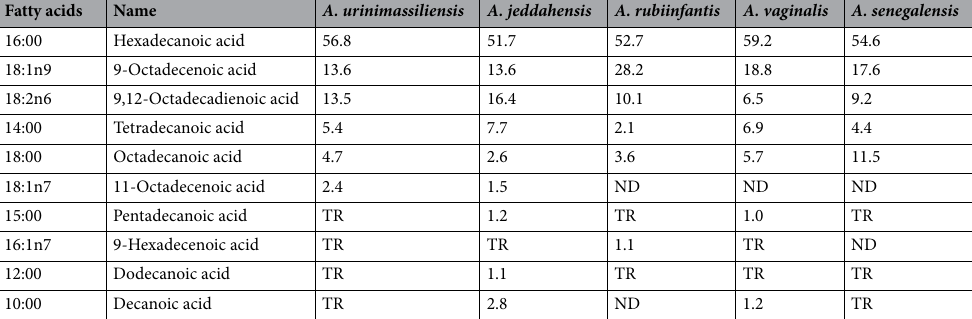
Table 3. Cellular fatty acid composition (%) of Anaerococcus urinimassiliensis sp. nov, Marseille-P2143 T compared with other Anaerococcus species. TR trace amounts < 1%, ND not